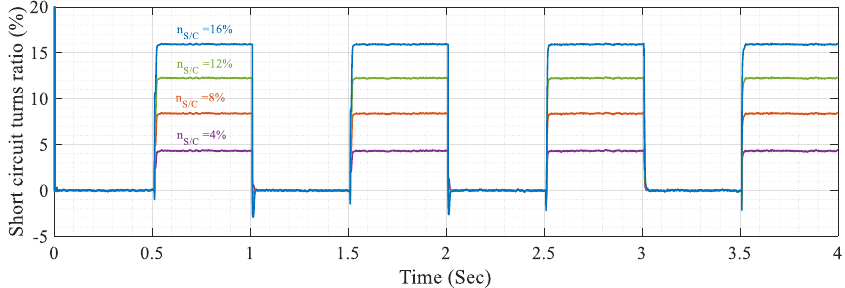
Figure 14. Estimation response in phase A at a frequency of 50 Hz with load variation from 0.75 to 3 A and 7.5 A step.